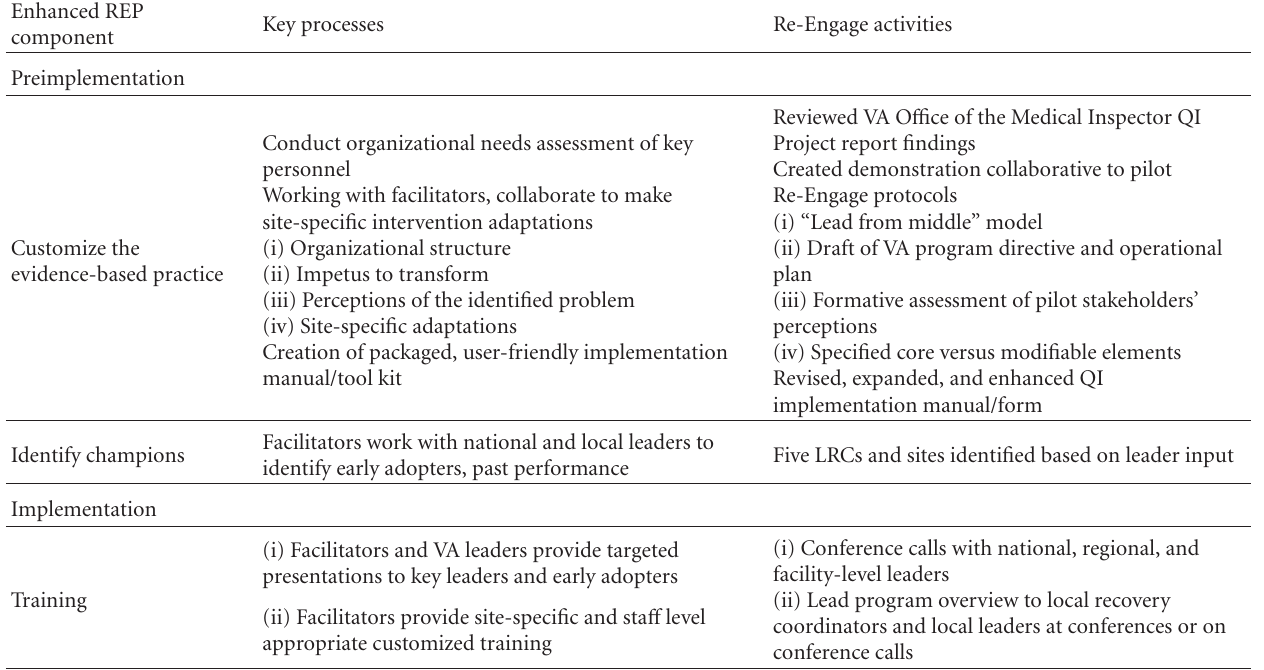
Table 1: Application of the Enhanced REP framework to